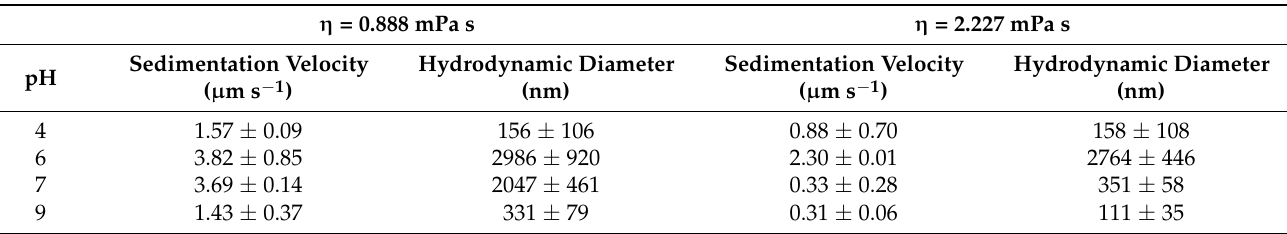
Table 1. Measurement of the sedimentation velocity and the corresponding hydrodynamic diameter of the samples in the sedimentation analyzer.